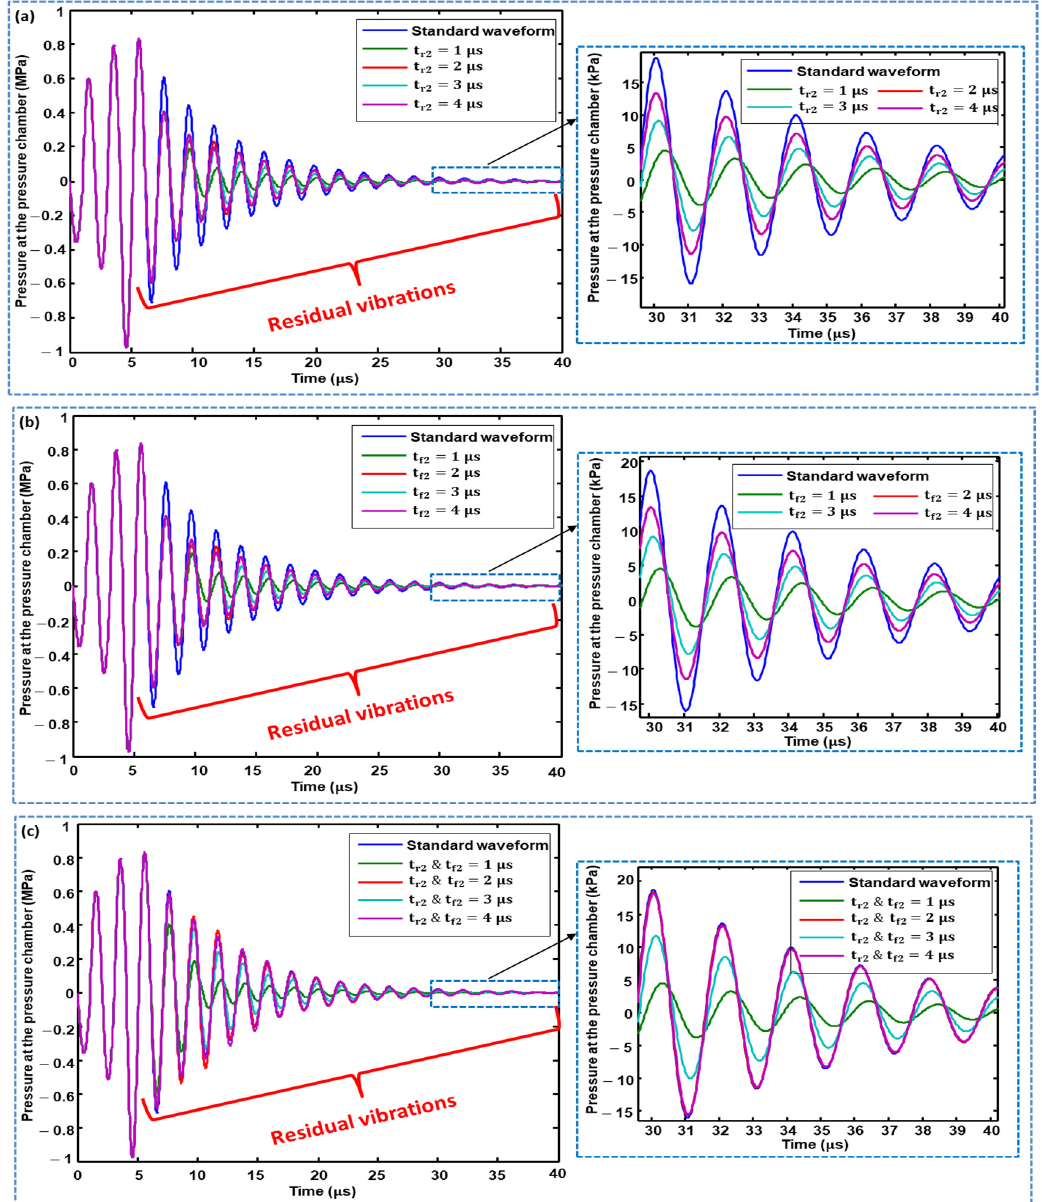
Figure 7. Effect of: ( a ) changing the rising time; ( b ) changing the falling time; and ( c ) simultaneously changing the rising and falling times of the second pulse of Waveform 01 on residual vibrations.